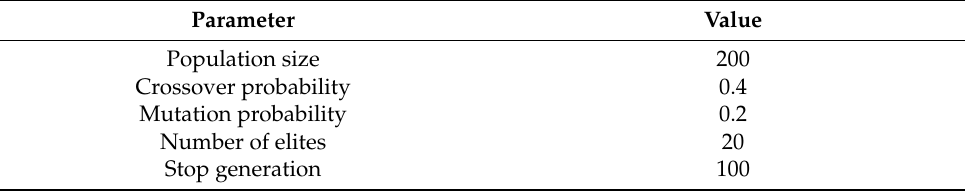
Table 4. The parameters of the genetic